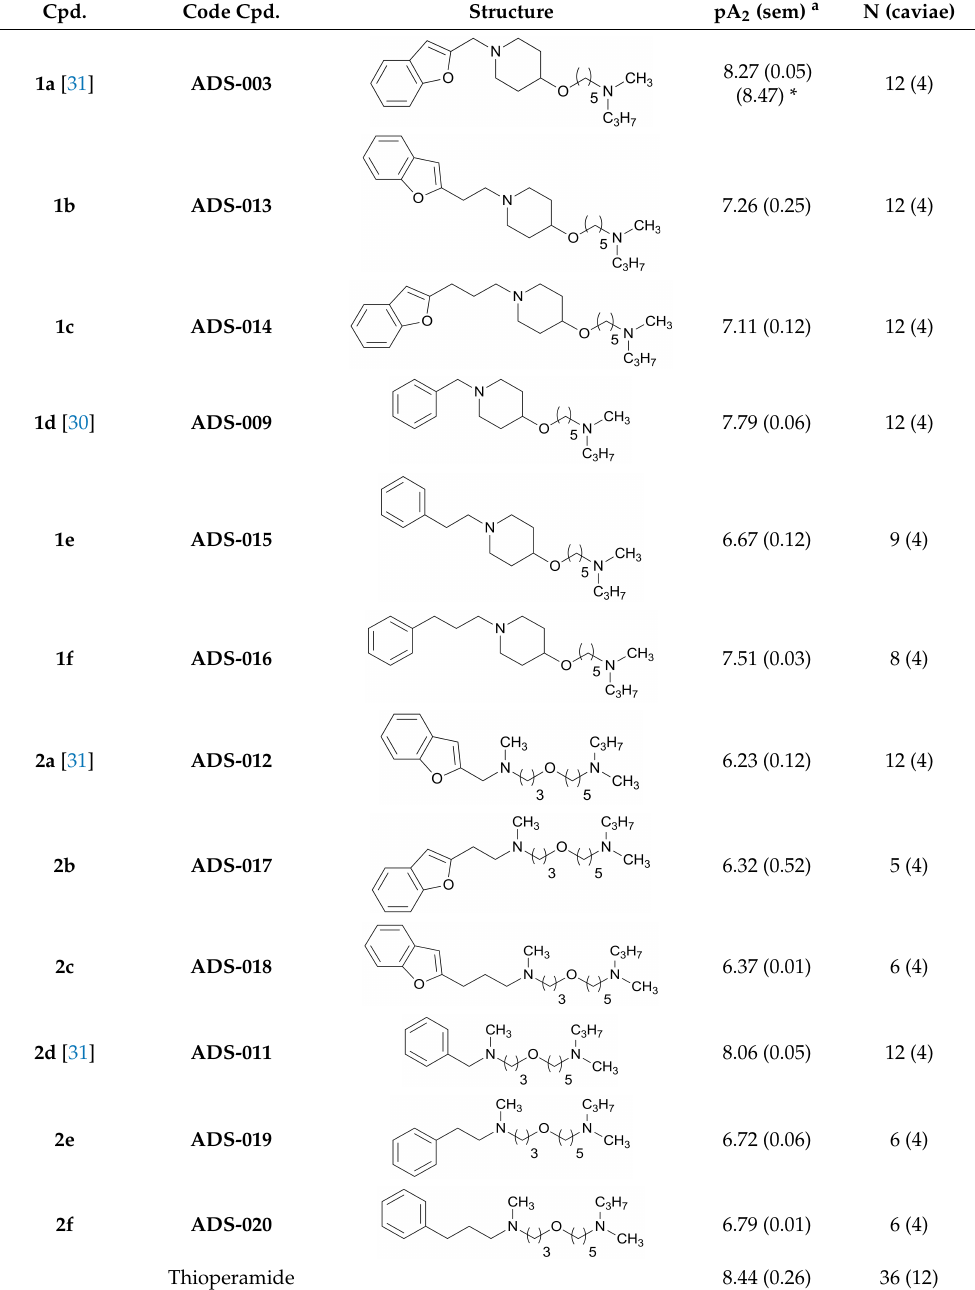
Table 1. H 3 antagonistic potency of 4-hydroxypiperidine derivatives ( 1a – f ) and their 3-(methyl-amino) propyloxyanalogues ( 2a – f ) as tested in the in vitro test system in the guinea pig jejunum.